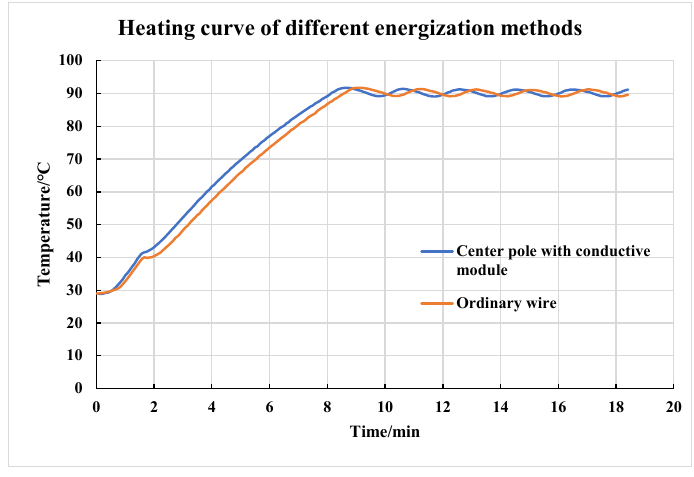
Figure 24. Heating curve of the different energization methods.